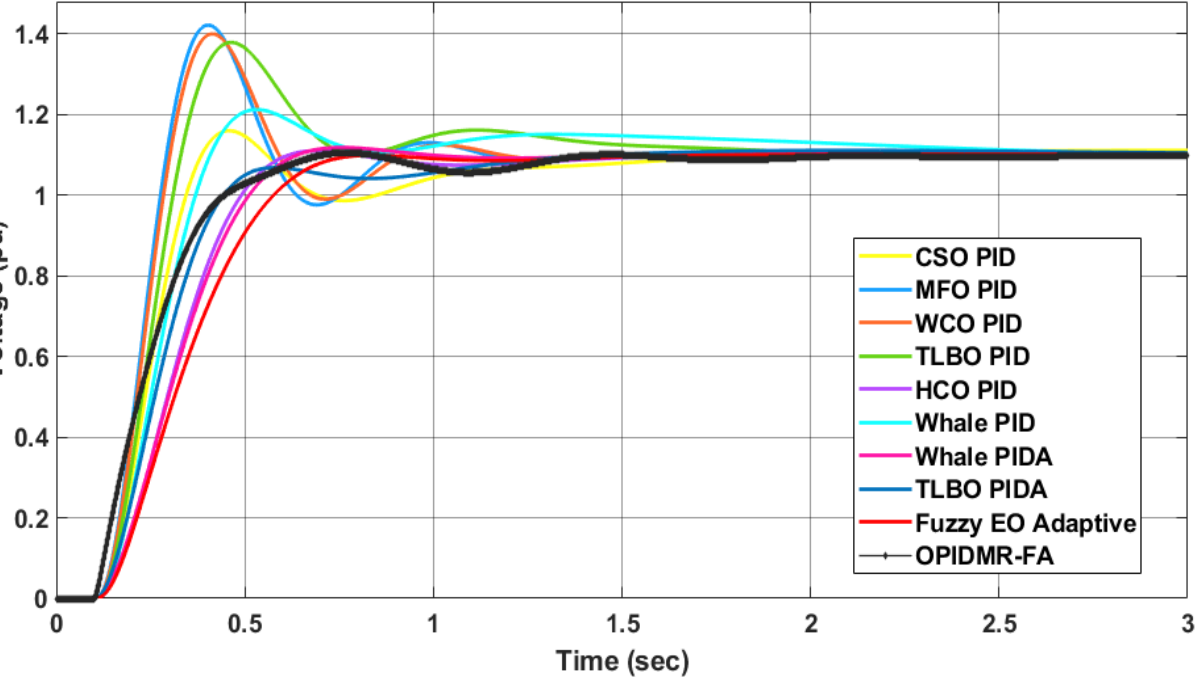
Figure 10. Magnified view of Figure 9. 4.3. Case Study 3 In this case, a 0.9 p.u. step-change on the voltage reference was used. Figures 11 and 12 demonstrate the transient responses of all controllers in this case. Again, the proposed OPIDMR-FA had a maximum overshoot that was 5.5% lower than the CSO PID, 32.2% lower than the MFO PID, 27.7% lower that the WCO PID, 26.6% lower than the TLBO PID, 3.3% lower than the HCO PID, and 11.11% lower than the whale PID. In addition, the dynamic response of the OPIDMR-FA was slightly better than the whale PIDA, TLBO PIDA, and fuzzy EO PID.